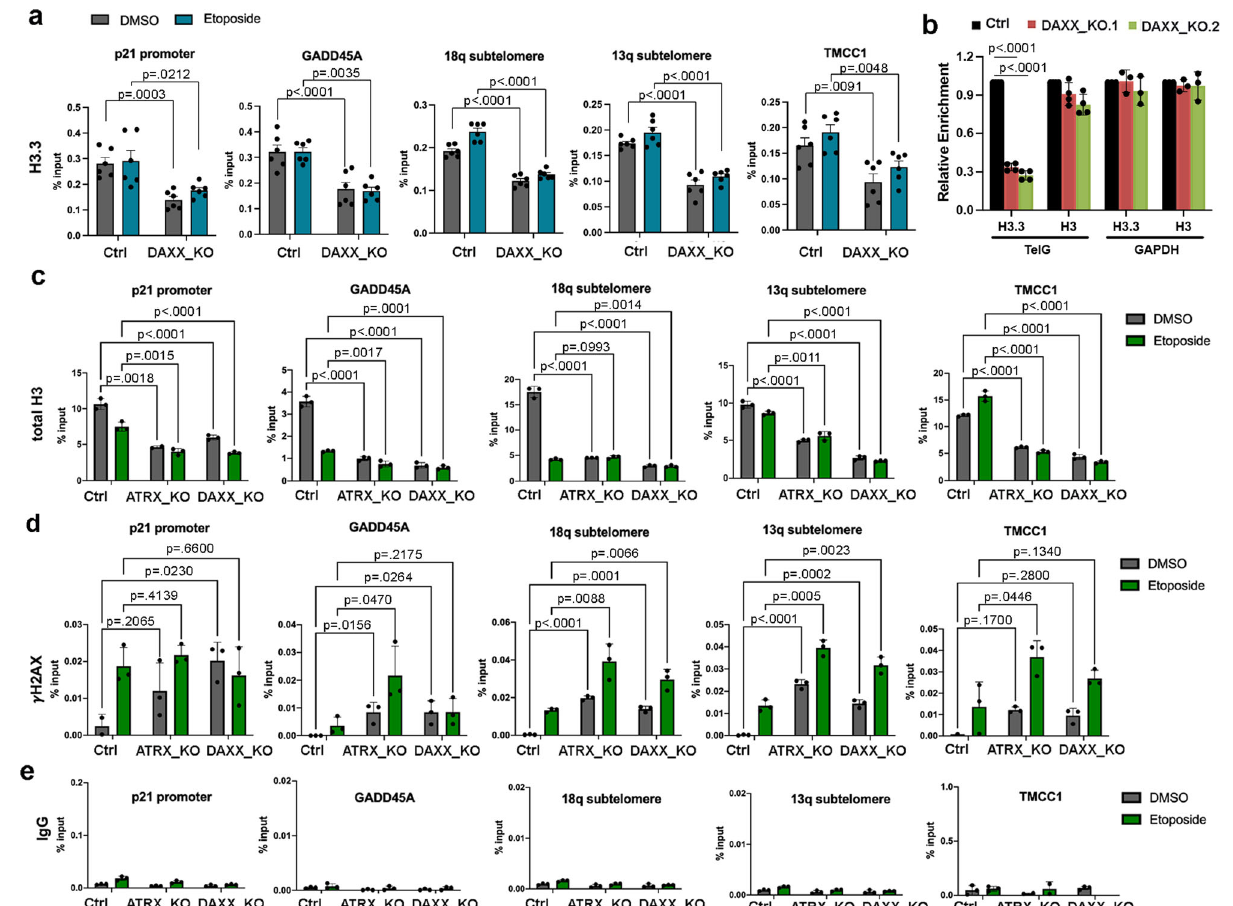
Fig. 7 | Altered histone composition at p53-binding sites in DAXX _KO and ATRX_KO ALT-like cells. a H3.3 ChIP-qPCR in Ctrl or DAXX_KO cells treated with DMSOoretoposideatp21promoter,GADD45A,18qsubtelomere,13qsubtelomere, orTMCC1geneloci. b ChIP-qPCRassayforH3.3orH3probedfortelomereDNAor control GAPDH DNA in Ctrl or DAXX_KO cells. c Total H3 ChIP-qPCR in Ctrl,